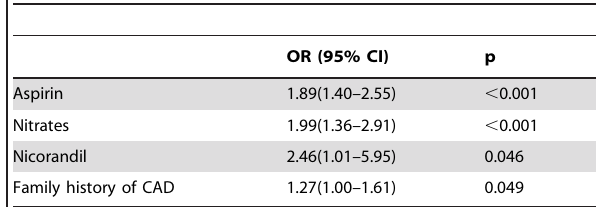
Table 2. Multivariate analysis for predictors of pre-infarction